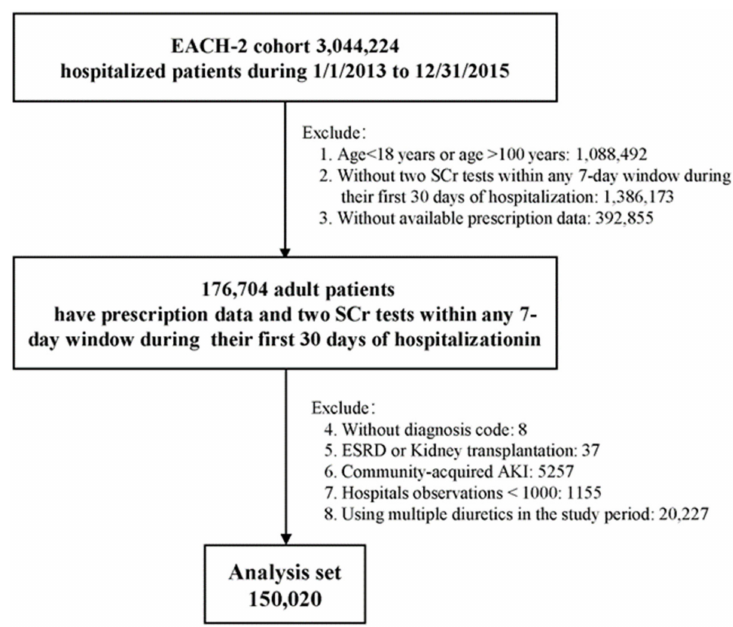
Figure 1. Flowchart of the study